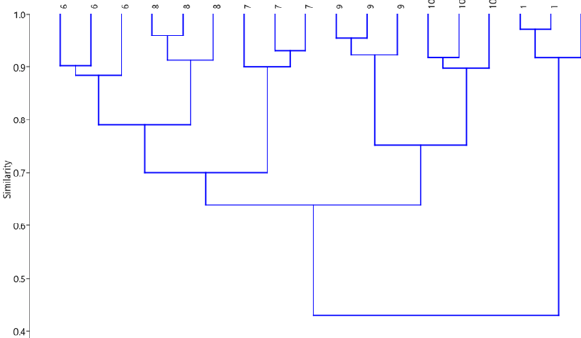
Figure 1. Ward tree of morphological data of the selected popula- tions of P.